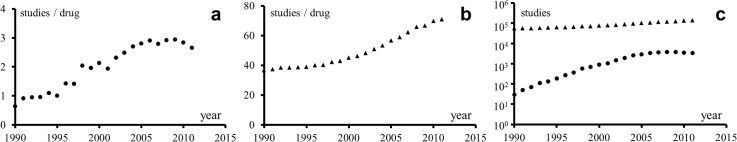
Average number of studies per drug per year.(a) Clinical. (b) Literature. (c) Number of studies in each dataset per year: Literature (triangles), Clinical (circles).